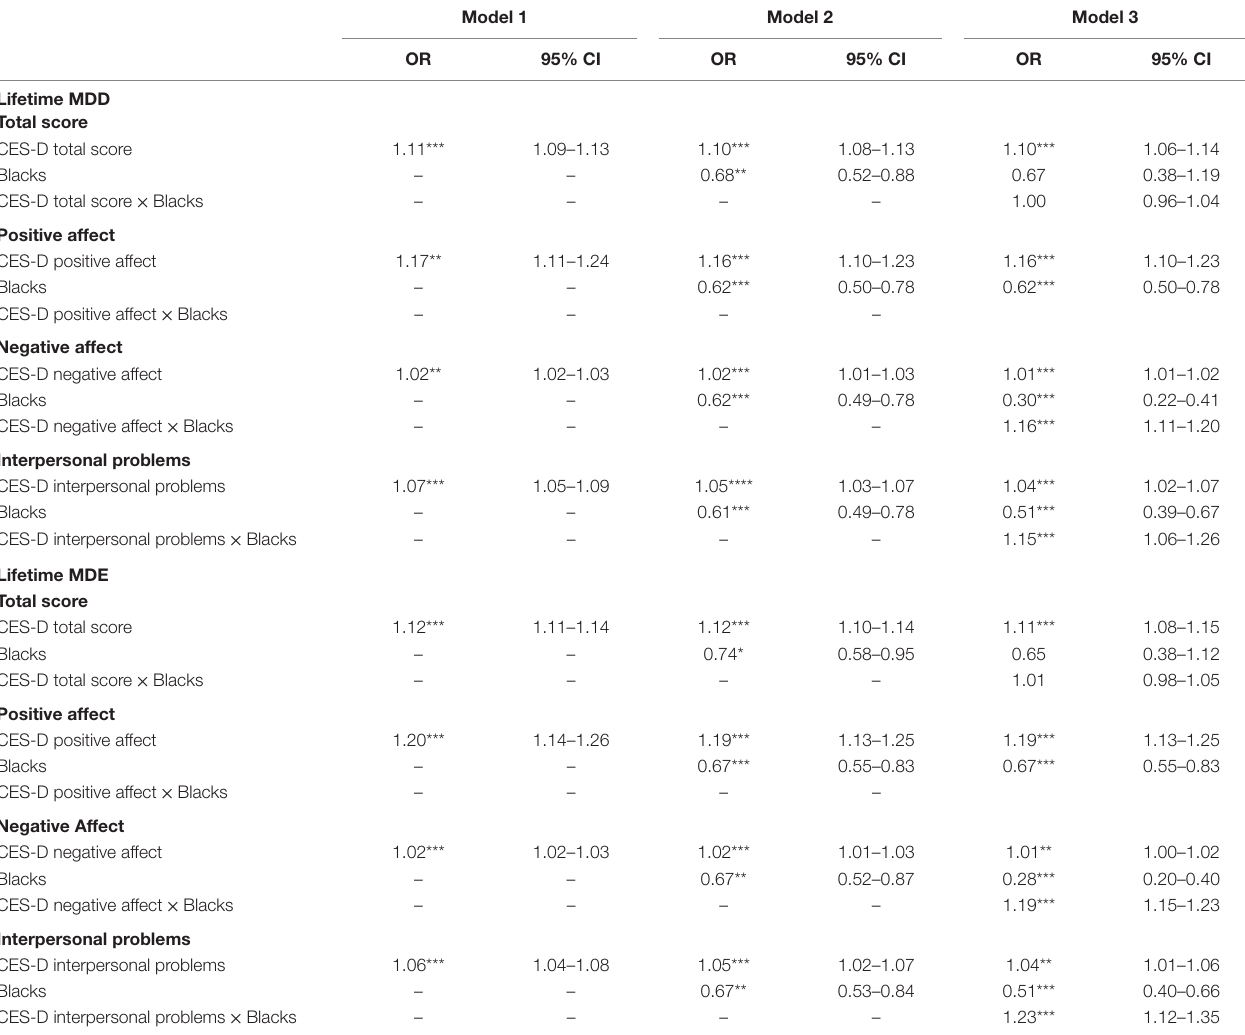
TaBle 3 | summary of regressions on the associations between ces-D factors and ethnicity on lifetime depressive disorders in the pooled